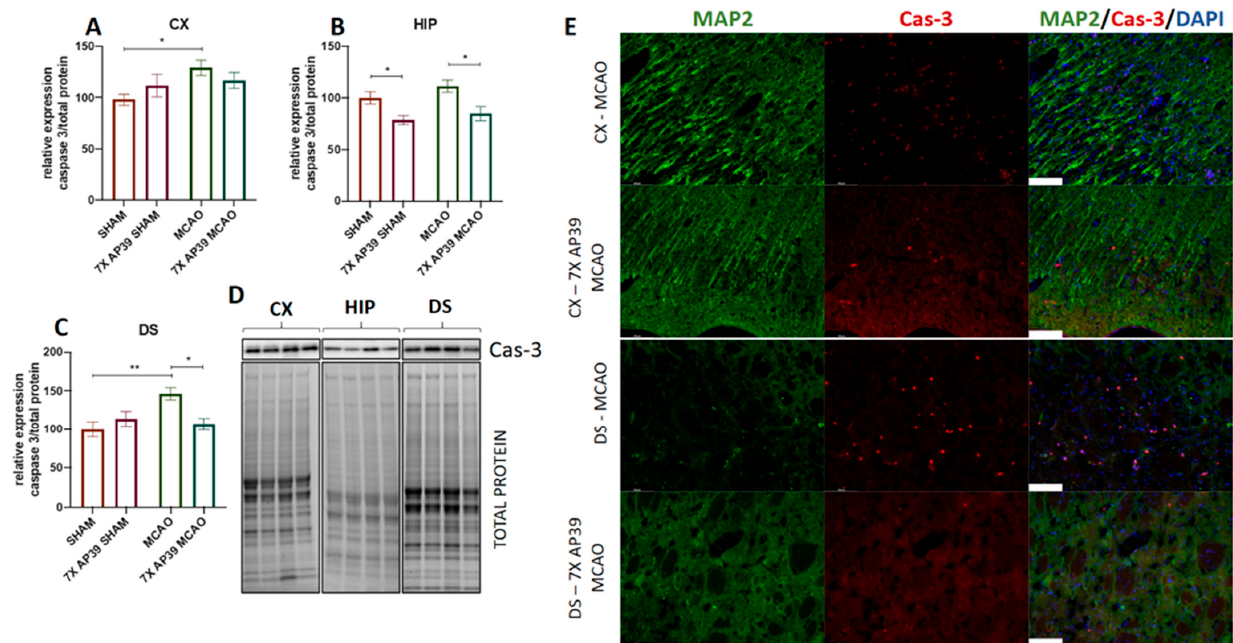
Figure 9. The effect of MCAO and AP39 on the level of the cleaved form of caspase 3 ( A ) in the frontal cortex (CX), ( B ) in the hippocampus (HIP) and ( C ) in the dorsal striatum (DS). ( D ) Immunoblots representative for the CX, HIP and DS for cleaved caspase 3, together with the total protein amount visualized by the stain-free technique. The order of samples is the same as in the graphs. n = 6, one-way ANOVA, followed by Sidak’s correction for post hoc comparisons; * p < 0.05, ** p < 0.01 vs. MCAO or SHAM. Data are presented as the mean ± SEM. ( E ) Representative photographs of brain sections double-immunostained against the neuronal marker, microtubule associated protein 2 (MA2, green) and cleaved caspase 3 (Cas-3, red). Stained sections were mounted with a DAPI-containing medium for nuclei staining (blue). Photographs are focused on the motor cortex and the dorsal striatum. Photographs for the hippocampus are not shown, since there were no clear changes between SHAM and MCAO on the fluorescence level. Scale bar = 100 µm.